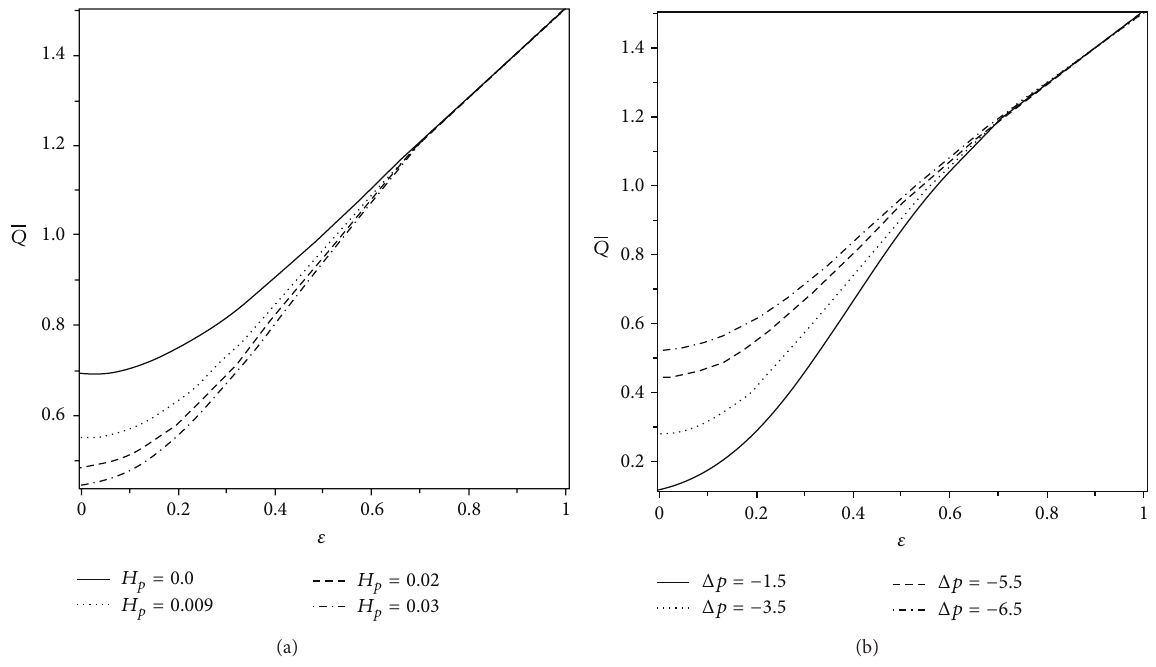
Figure 4: Variations of 𝑄 with 𝜀 for different values of (a) 𝐻 𝑝 when Δ𝑝 = −5.5 and (b) Δ𝑝 when 𝐻 𝑝 = 0.03 . The other parameters are 𝛼 = 0.4 and 𝛽 = 0.4